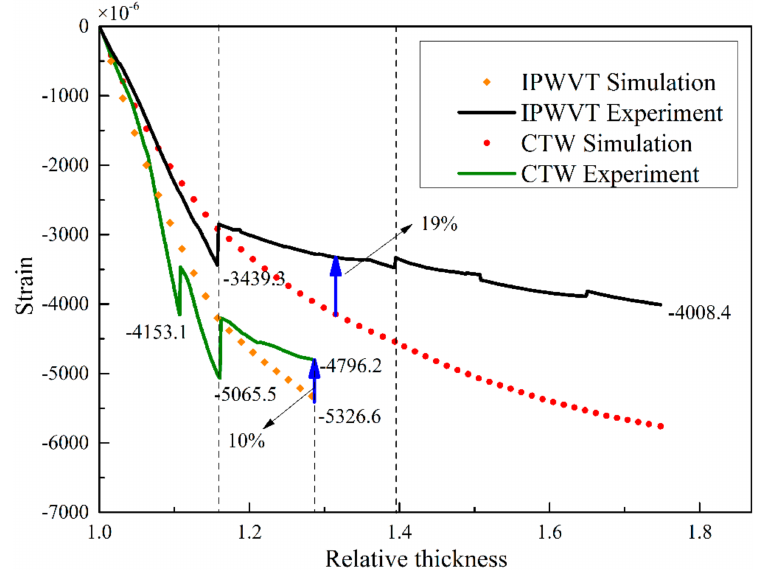
Figure 9. Comparison between online strain monitoring results and simulation